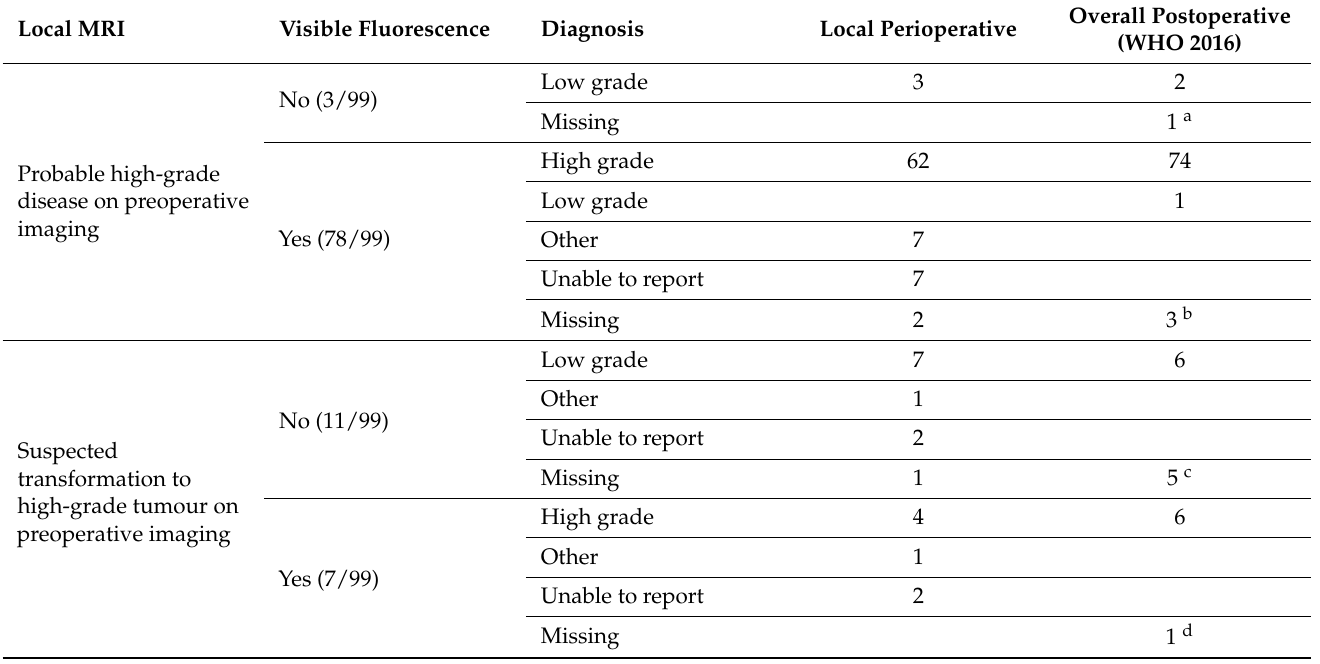
Table 2. Summary of local perioperative and central formal diagnosis in patients with the probable high-grade disease and suspected transformation to high-grade disease stratified by visible fluorescence.